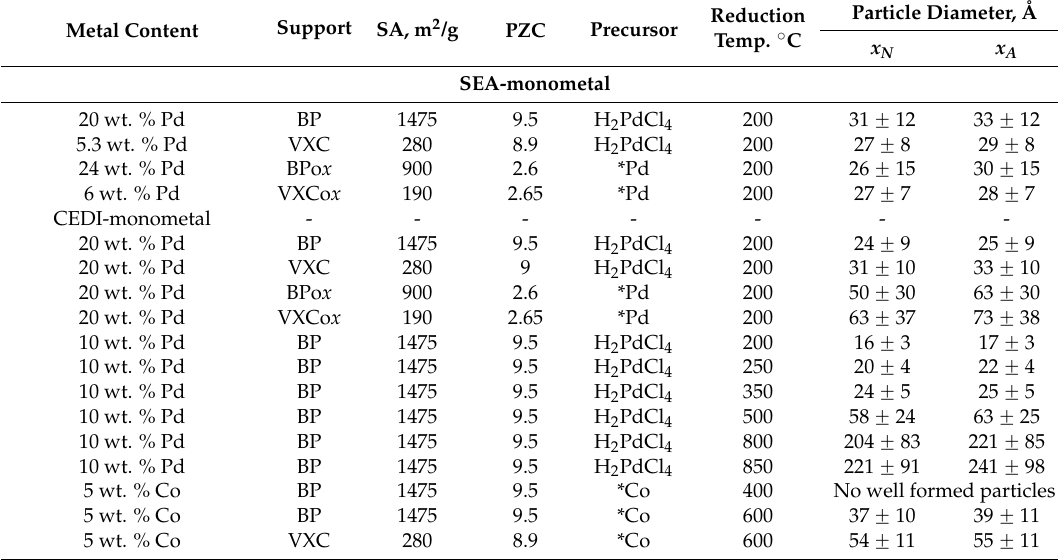
Table 1. Physical characteristics of the catalysts prepared by SEA, Charge Enhanced Dry Impregnation (CEDI) and Dry Impregnation